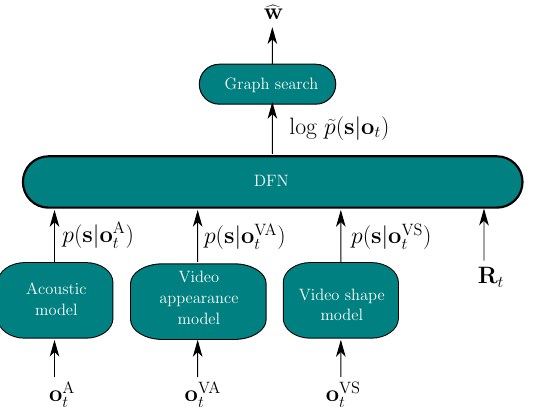
Figure 1. Audio-visual fusion based on the DFN, applied to one stream of audio and two streams of video